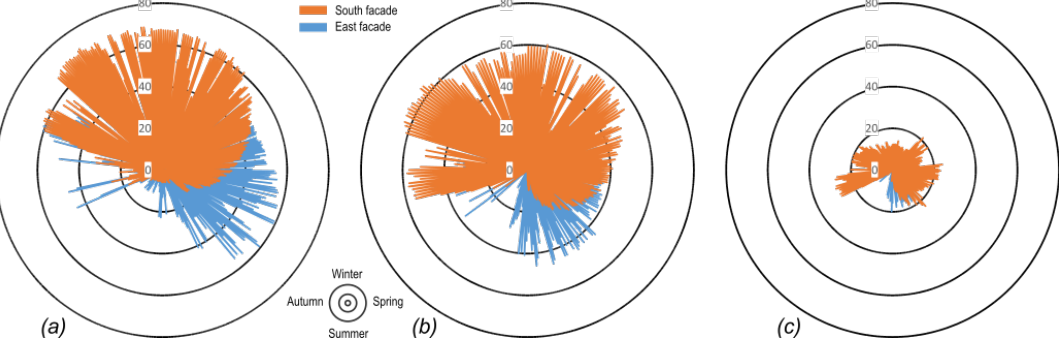
Figure 9. Yearly variation of the thermally induced temperature gradients (K) in Mumbai for values of view angles of 0° ( a ), 30° ( b ) and 60° ( c ) for the worst combination of glass type/insulation type in Table 9. and 10.